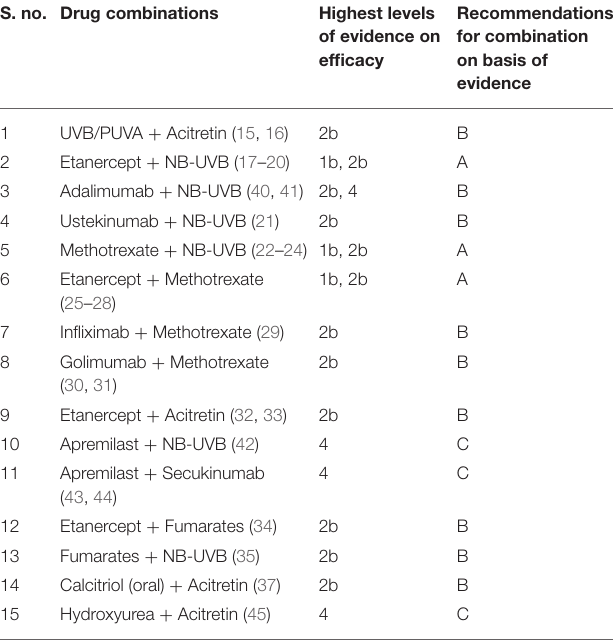
TABLE 2 | Summary of levels of evidence and strength of